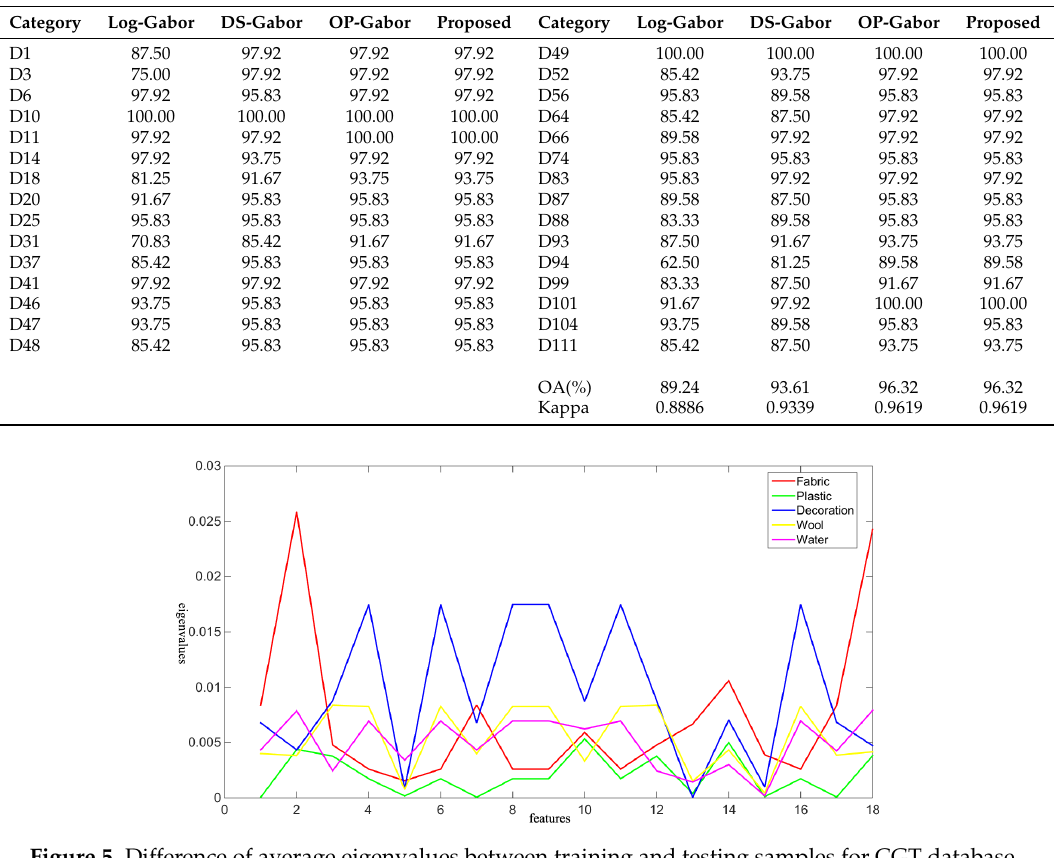
Figure 5. Difference of average eigenvalues between training and testing samples for CGT database.